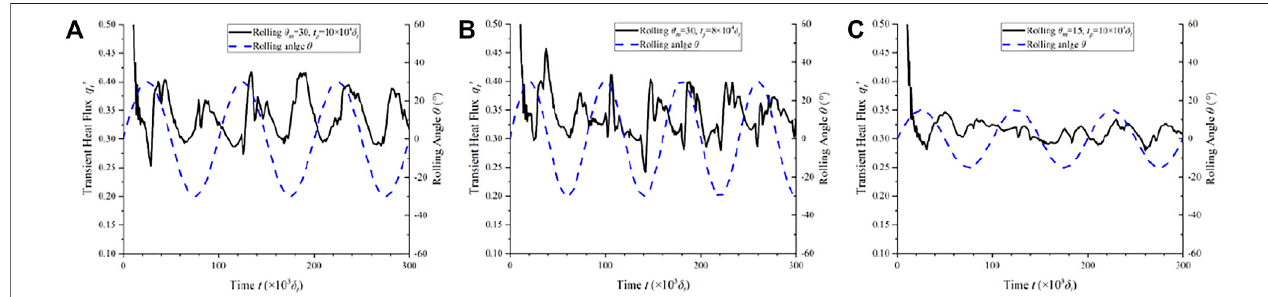
FIGURE 12 | Transient heat fl ux with different rolling parameters at nucleate boiling regime, Ja (cid:1) 0.142. (A) Maximum rolling angle θ r,m (cid:1) 30 ° , rolling period t p (cid:1) 10 × 10 4